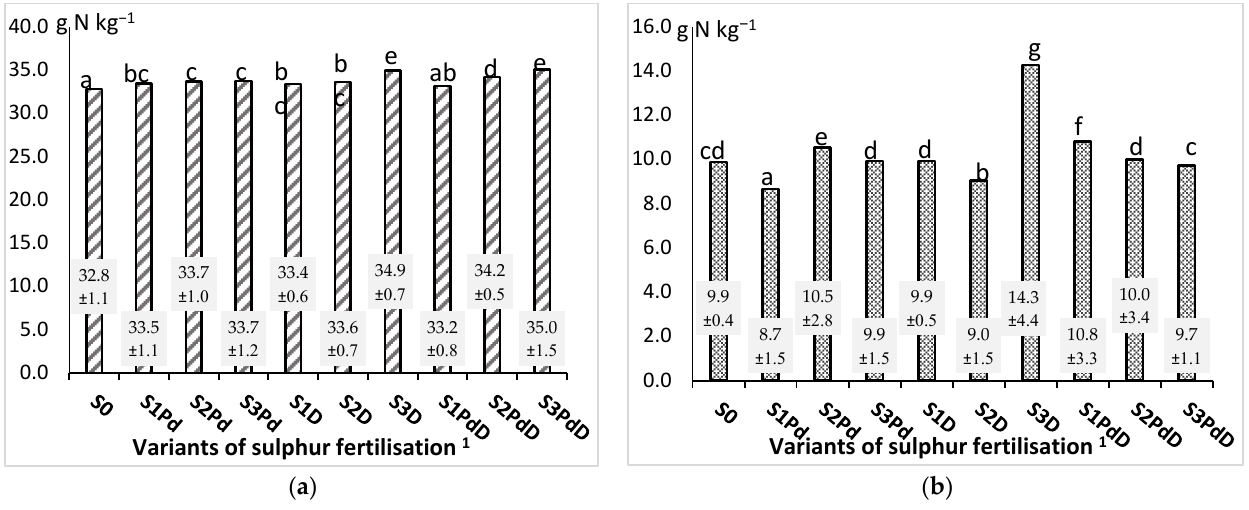
Figure 4. ( a ) Nitrogen content in the rape seeds on average for variants of sulphur fertilisation; ( b ) Nitrogen content in the rape straw on average for variants of sulphur fertilisation. 1 See Table 2; Means followed by the same letter are not statistically different at the α = 0.05 level. ± —standard deviation.